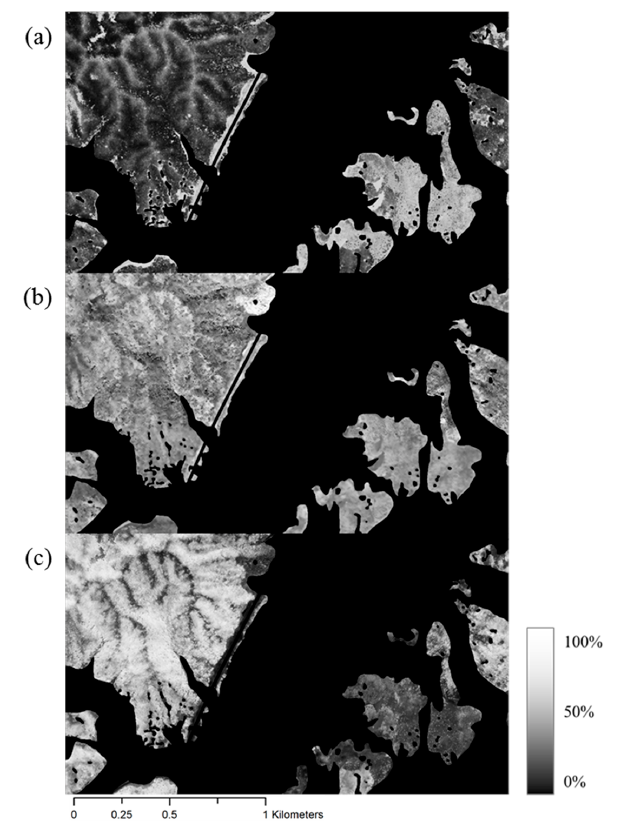
Figure 7. Probability maps of the ( a ) single-; ( b ) double-; and ( c ) triple-layered forests.